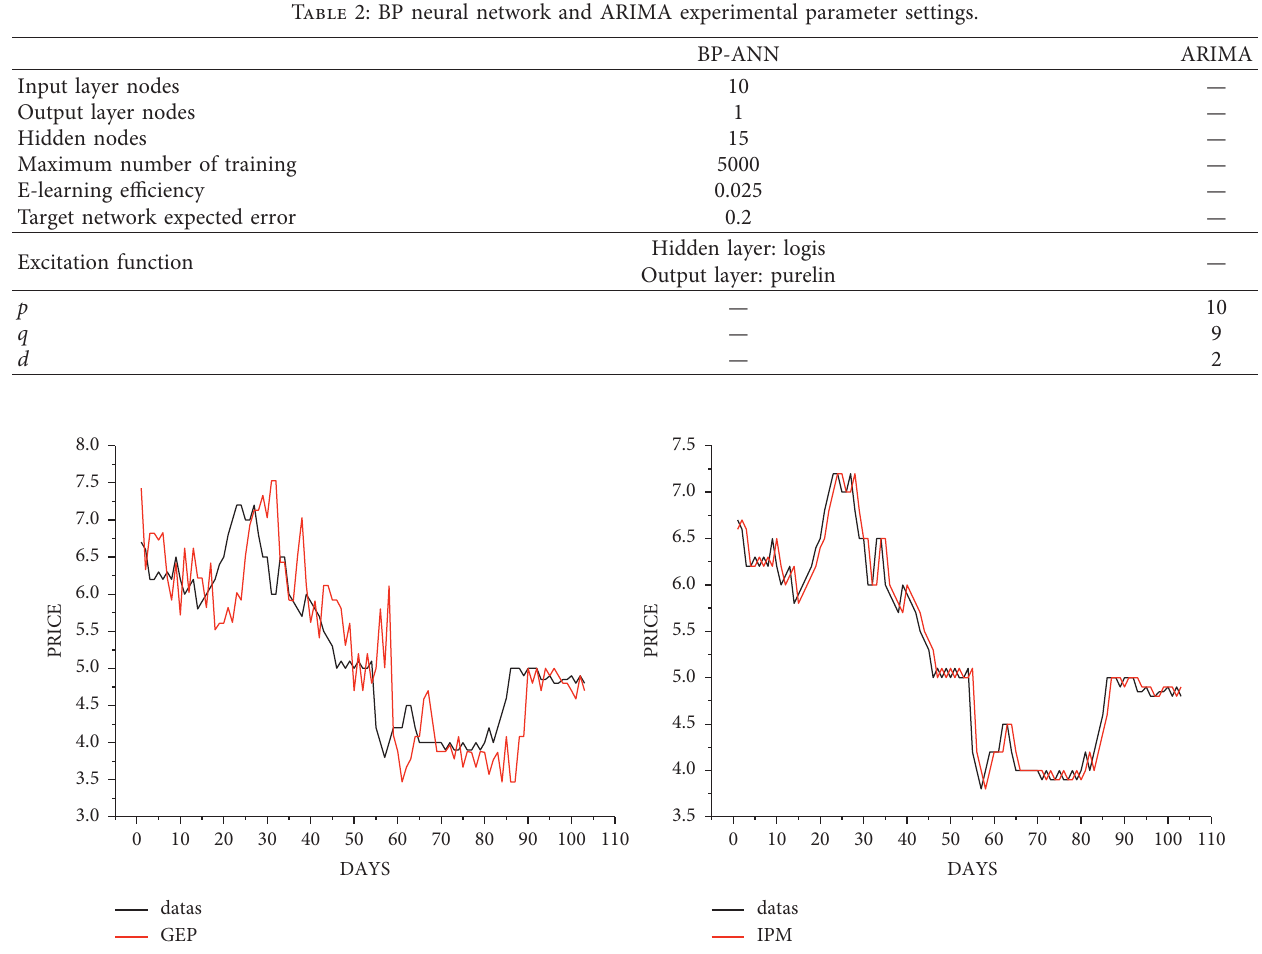
Figure 5: GEP-IPM regression prediction fitting effect of leek